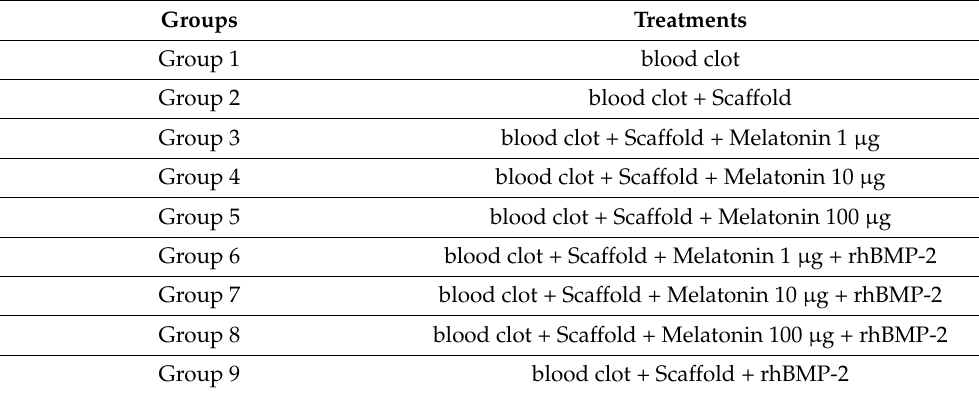
Table 1. Distribution of treatments and experimental